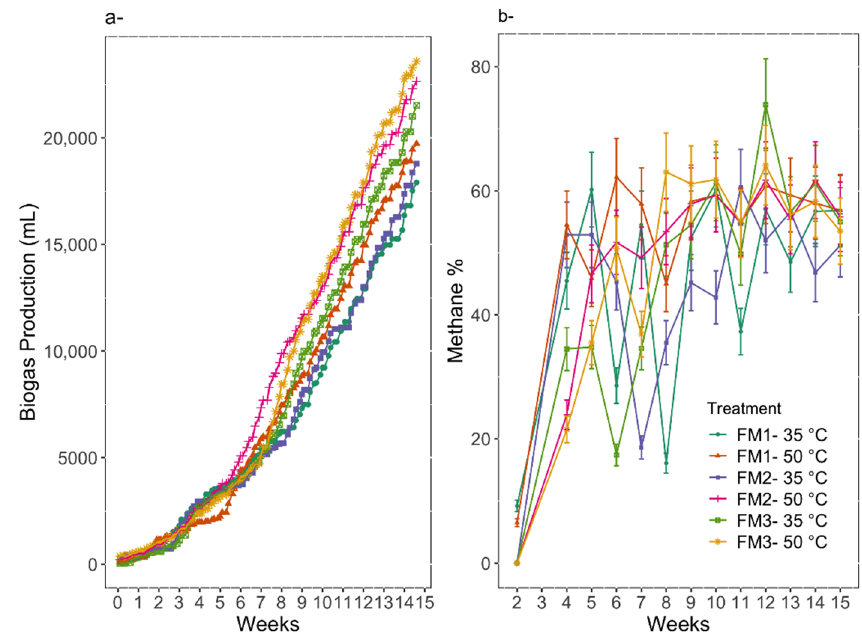
Figure 3. ( a ) Accumulated biogas production throughout the assay. ( b ) Methane content in the biogas, determined weekly. Each data point is the average of two replicates. Error bars show the standard error.